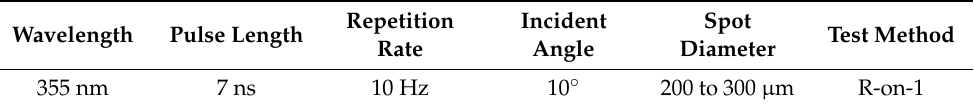
Table 3. LIDT test parameters for nanosecond laser at 355 nm